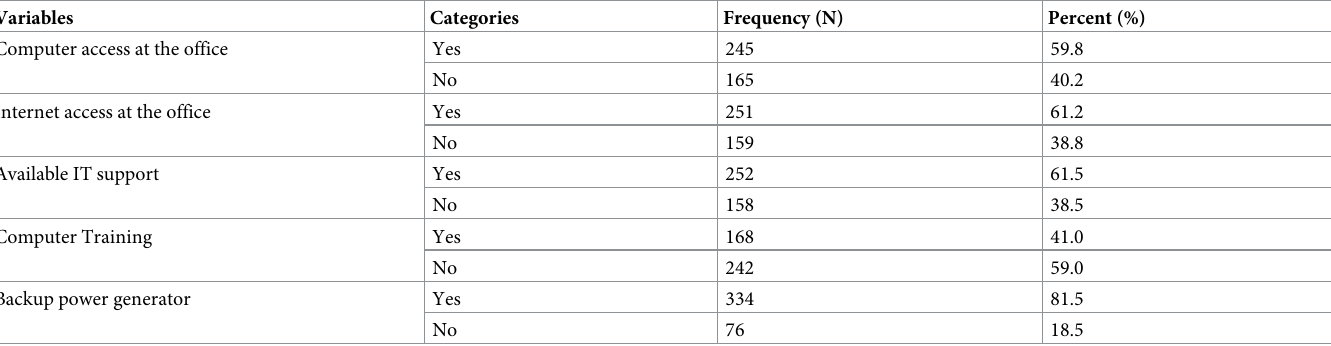
Table 3. Organizational factors for health professionals’ readiness towards telemedicine in private hospitals Amhara region 2021 (N = 410).